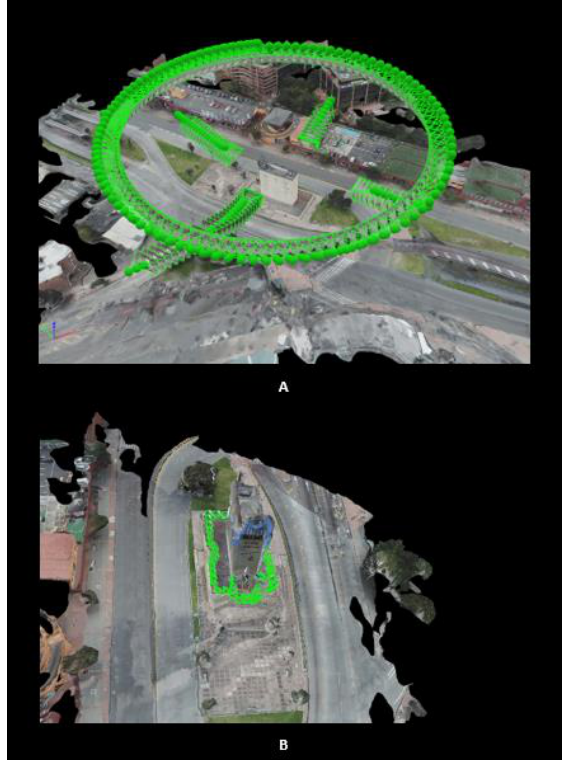
Figure 5: Distribution of Images of the Monument to Heroes from A) Canon Camera, B) Drone Flight Source: Own elaboration.